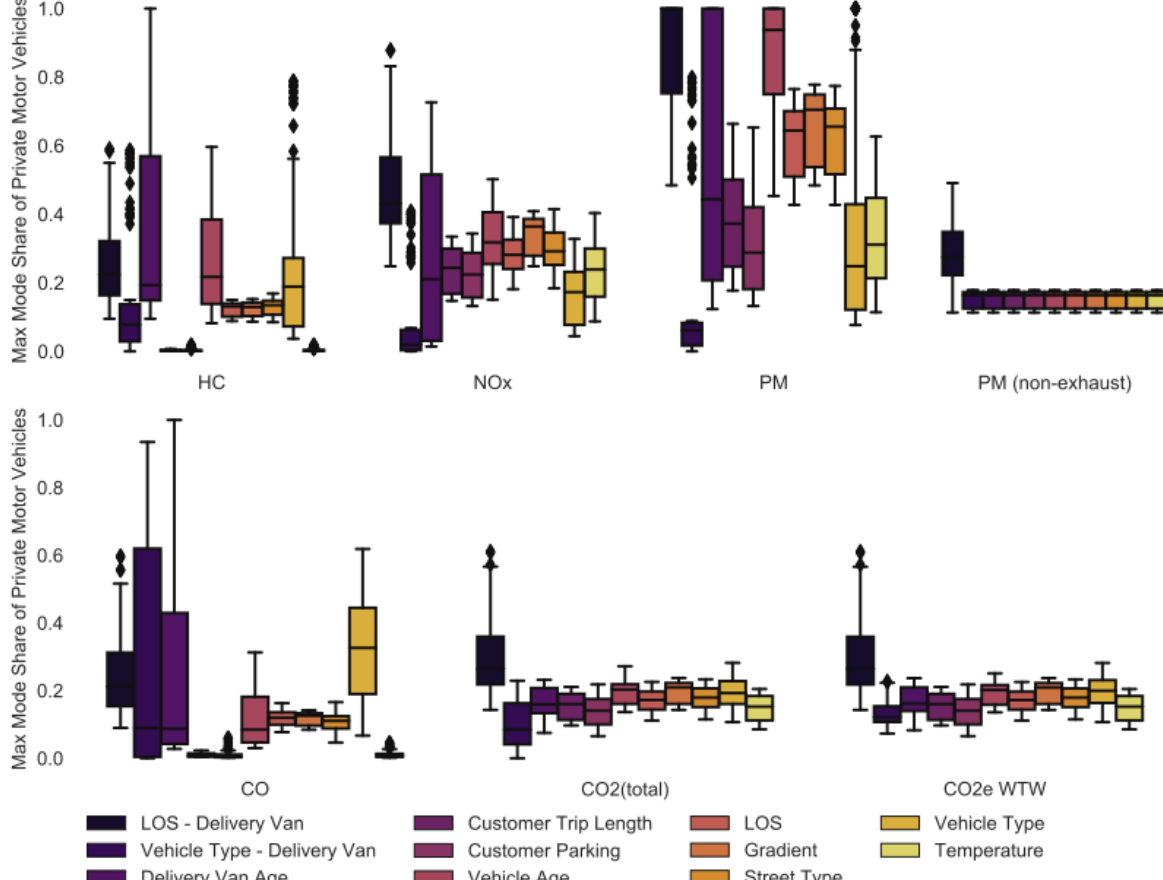
Figure 16. Variance in the maximum mode share.